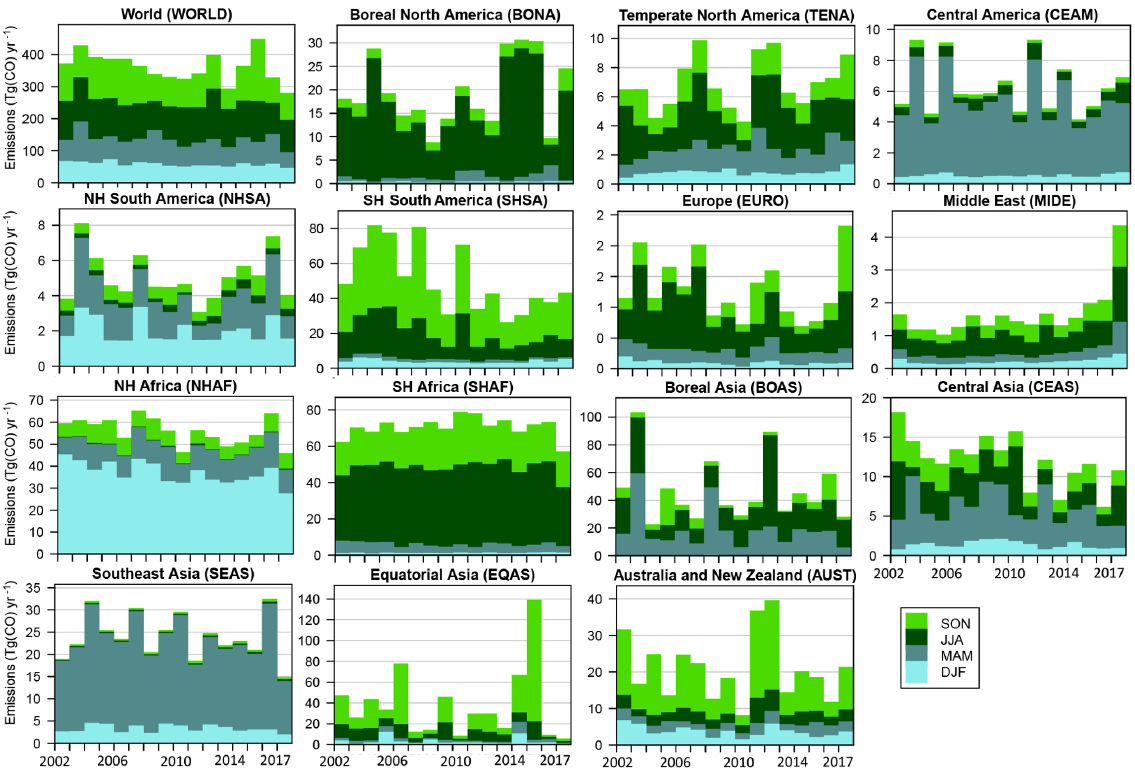
Figure 2. Cumulated seasonal GFAS biomass burning CO emissions at the global scale and in the 14 continental regions. Emissions are from GFASv1.0 in 2002 and from GFASv1.2 over the 2003–2017 period. Table 2. Mean CO emissions from vegetation fires and interannual variability (IAV). Mean emissions are calculated over the period 2002– 2017. The IAVs are given at the annual and seasonal